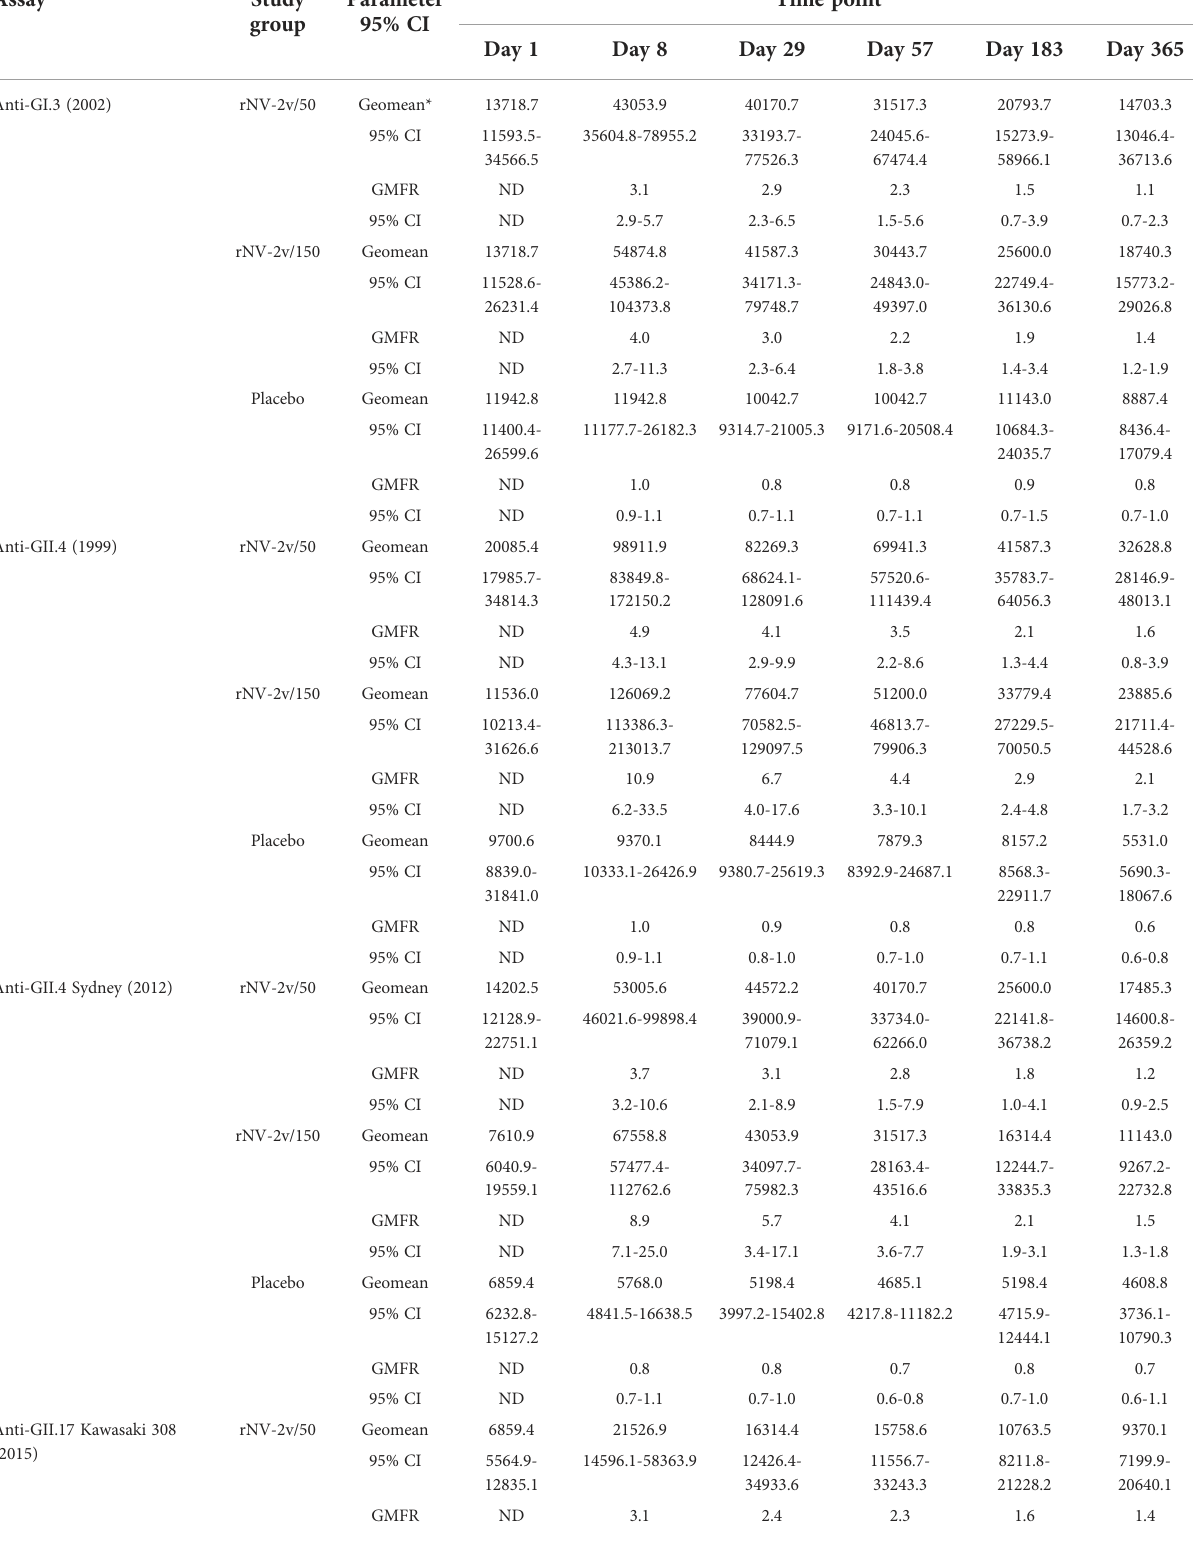
TABLE 3 Cross-reactive IgG antibody responses to non-vaccine antigens expressed as Geometric Mean Titres at scheduled time points. Assay